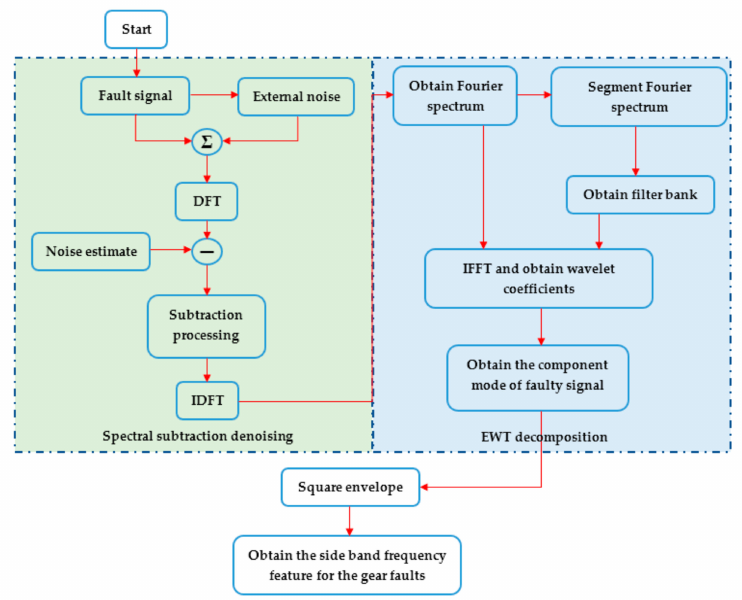
Figure 1. Flow chart of the fault diagnosis